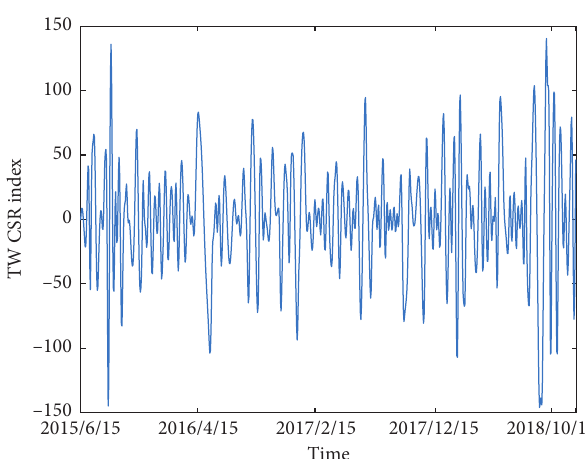
Figure 8: EMD analysis of the Taiwan CSR index used to get IMF2.